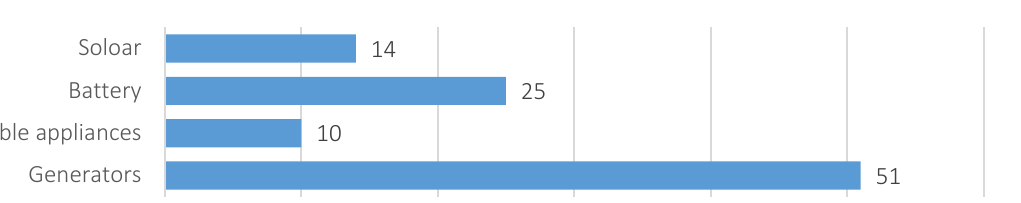
Figure 4. Ratings on maintenance